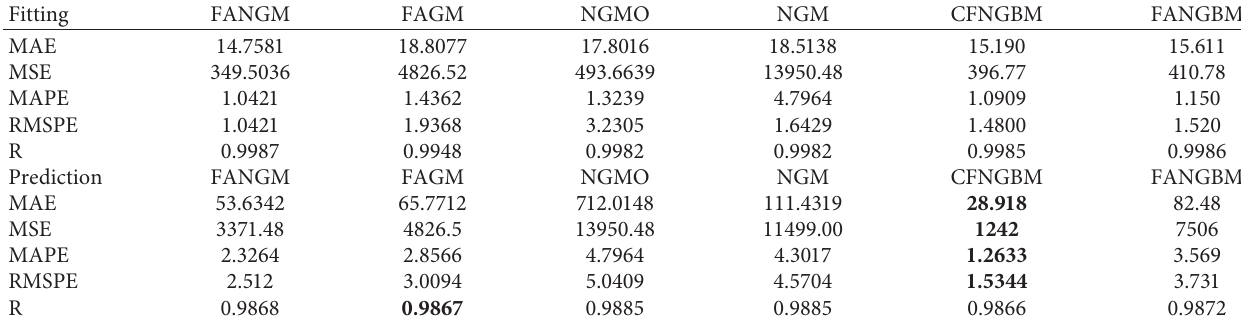
Table 9: Error metrics of CO